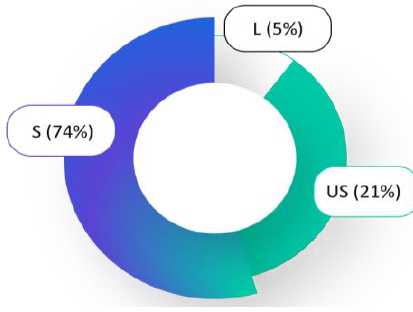
Figure 16. Classification by prediction horizon.